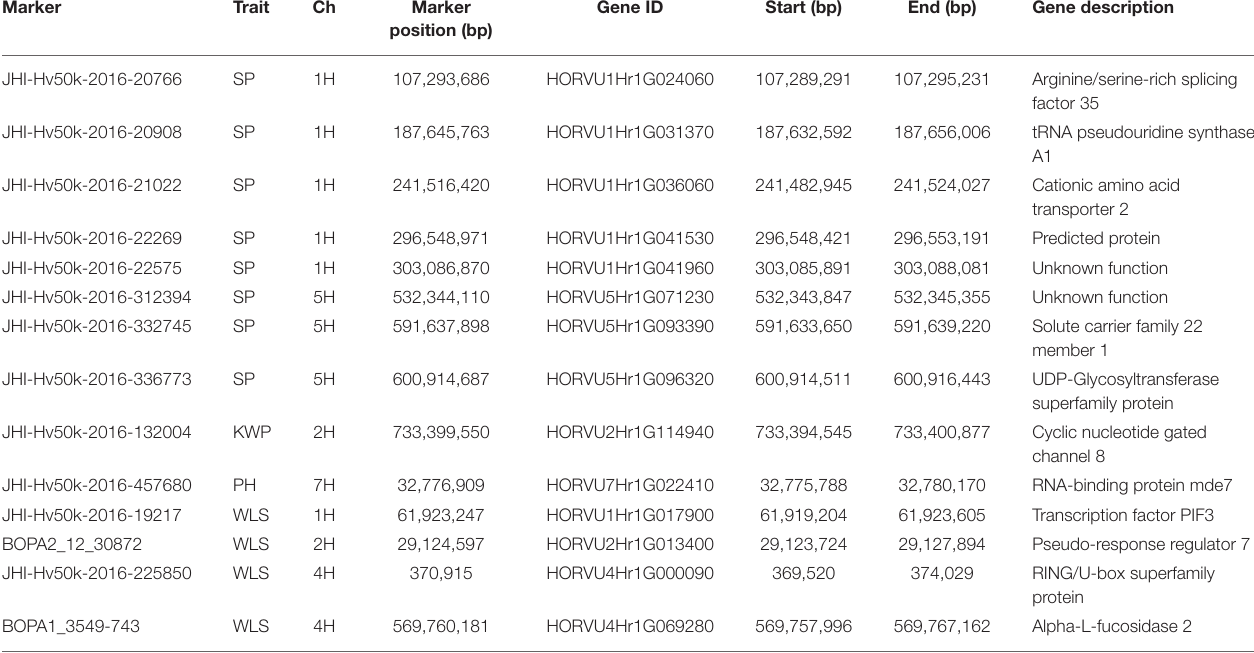
SP, spikes per plant; KWP, kernel weight per plant; PH, plant height; WLS, waterlogging score; Ch, chromosome number.